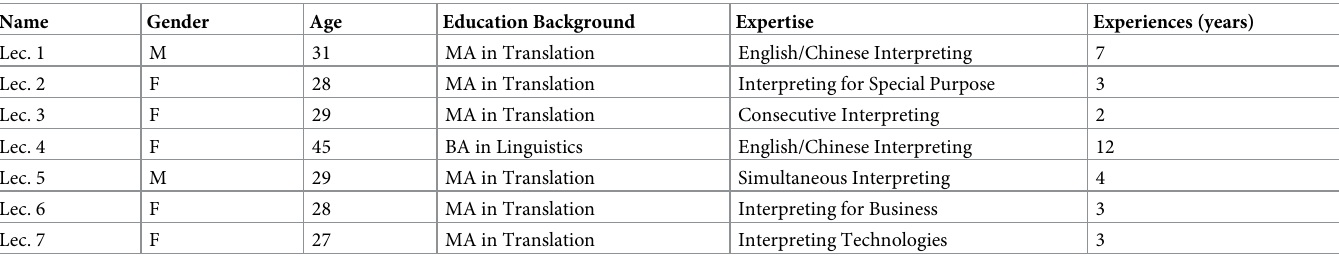
Table 1. Demographic information of participating